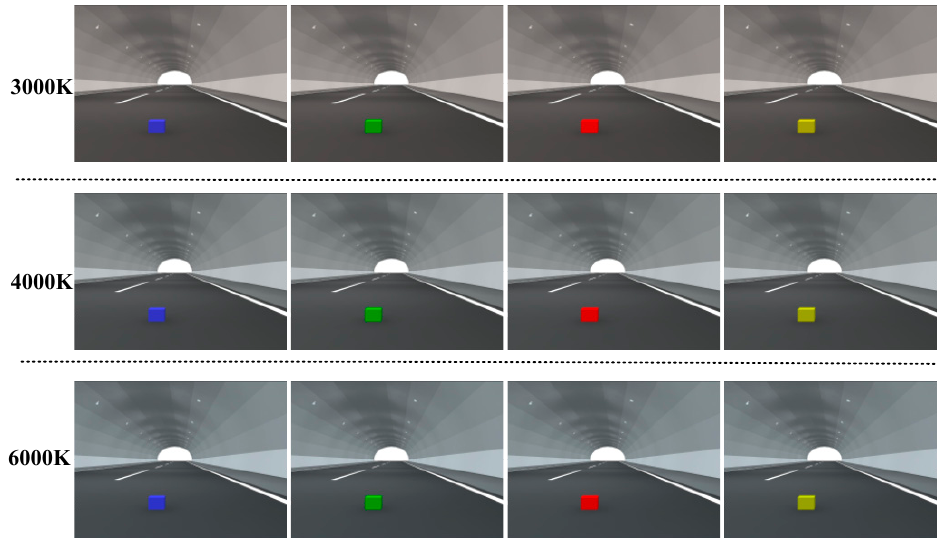
Figure 13. Images of the four-color targets.